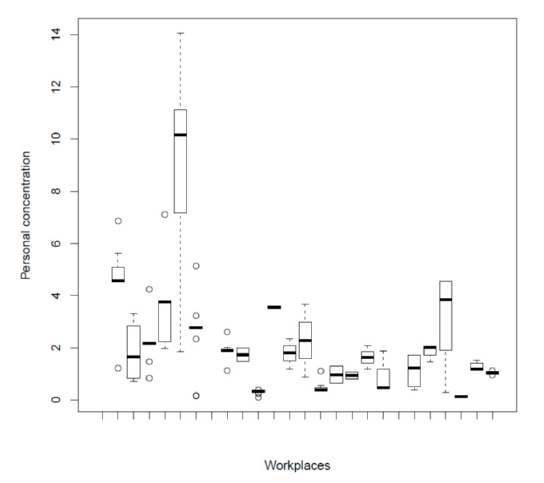
Figure 1. Flour dust levels in the different workplaces. Dust levels: mg/m 3 .